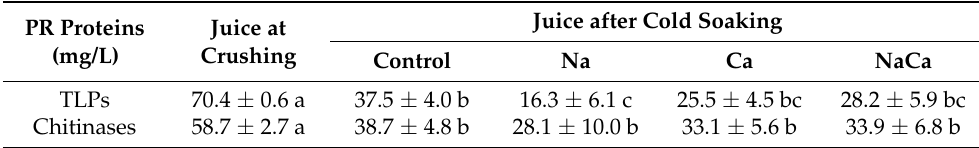
Table 2. Analysis of pathogenesis-related proteins in juice with and without bentonite